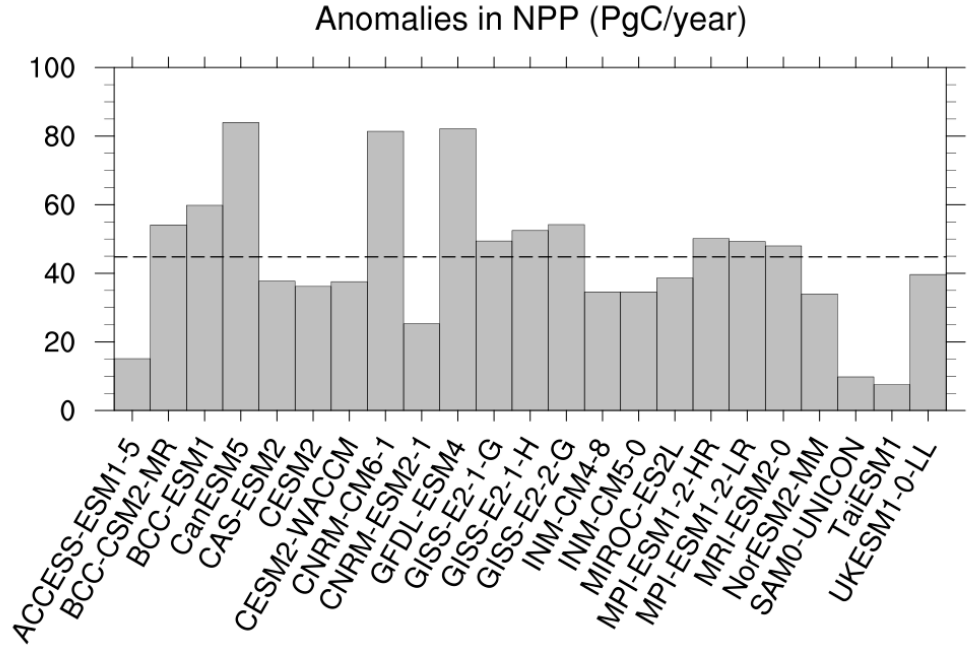
Figure 3. Global annual total NPP anomalies (PgC year − 1 ) between simulations of abrupt-4 × CO 2 and piControl for the CAS-ESM2 and the 22 CMIP6 models. The dashed line represents the multi- model ensemble value (MME).